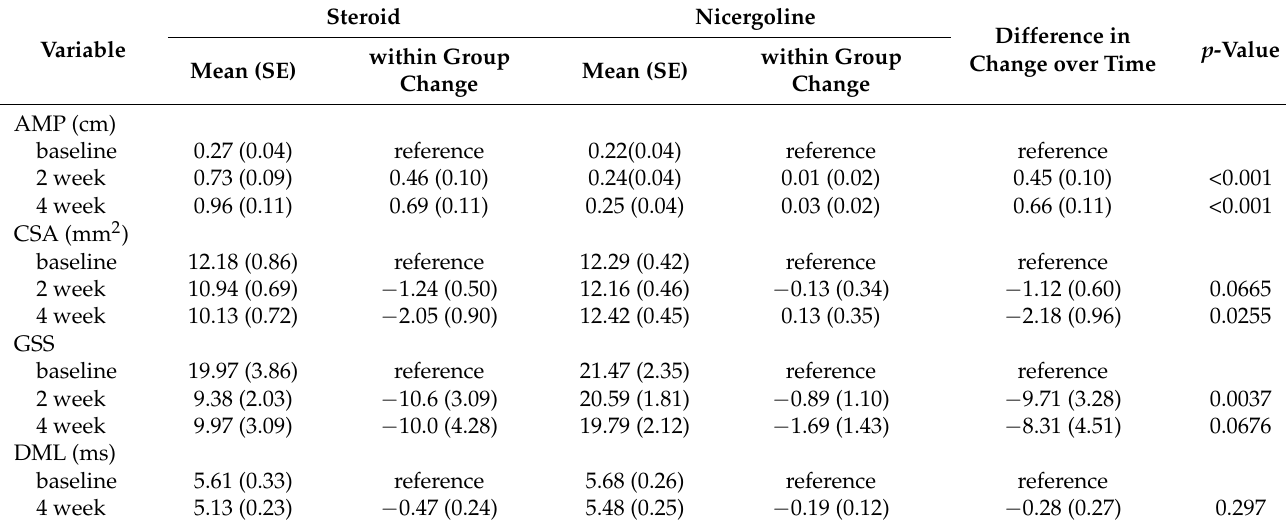
Table 2. Least squares means of AMP, CSA, GSS, and DML at the 1st (baseline), 2nd, and 4th week with a mixed- effects model *.